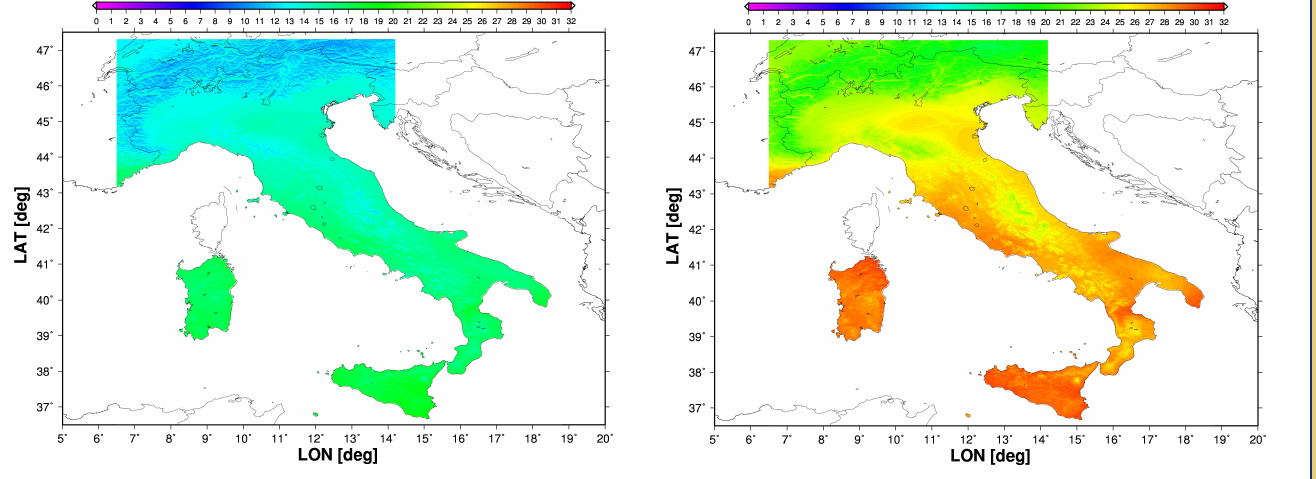
Figure 5. As in Fig. 3, but for